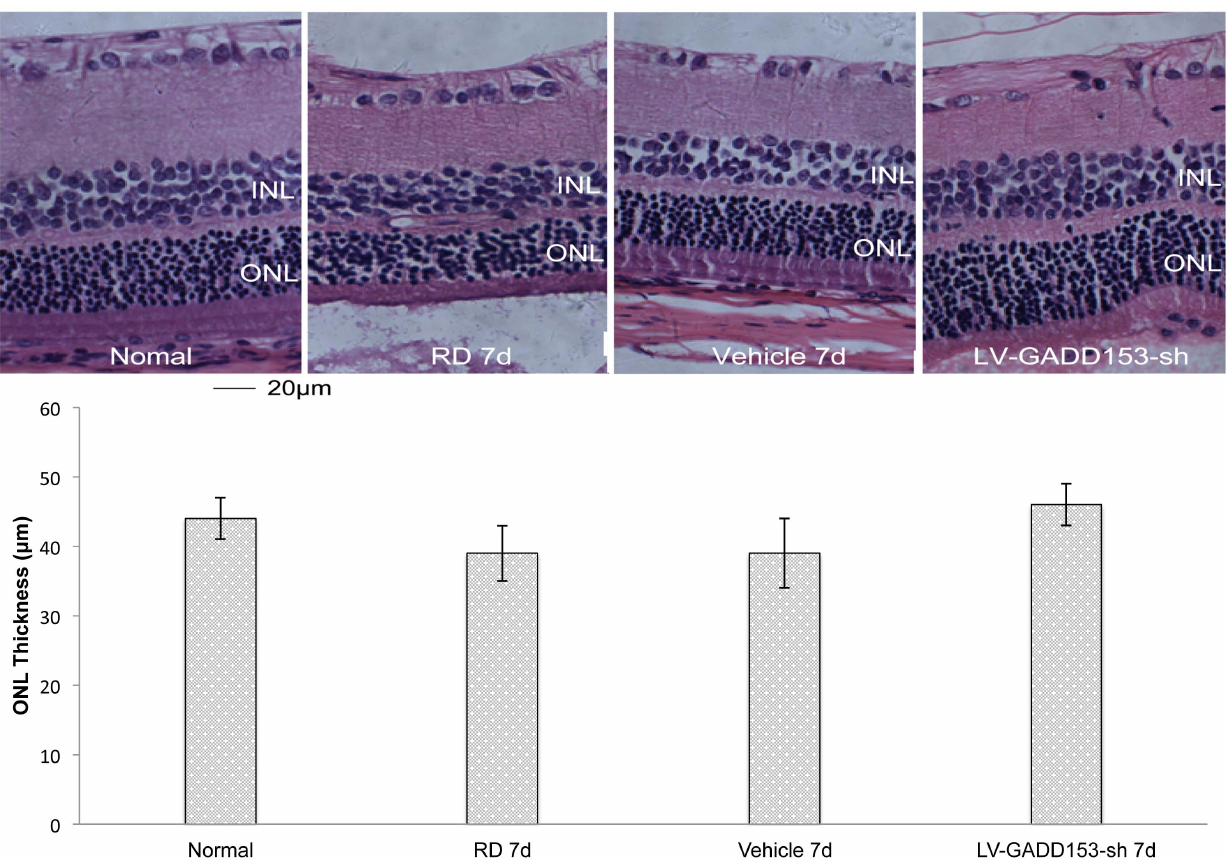
Figure 2. Analysis of ONL thickness in the retina after RD. (A) Representative histopathological images of retina section from normal rat eyes and rat eyes treated with GADD153 RNA interference (LV-GADD 153-sh), vehicle, and non-treated (RD) after 7 days of experimental RD. (B) In all cases, treatment with LV-GADD 153-sh led to better preservation of ONL thickness than RD groups.